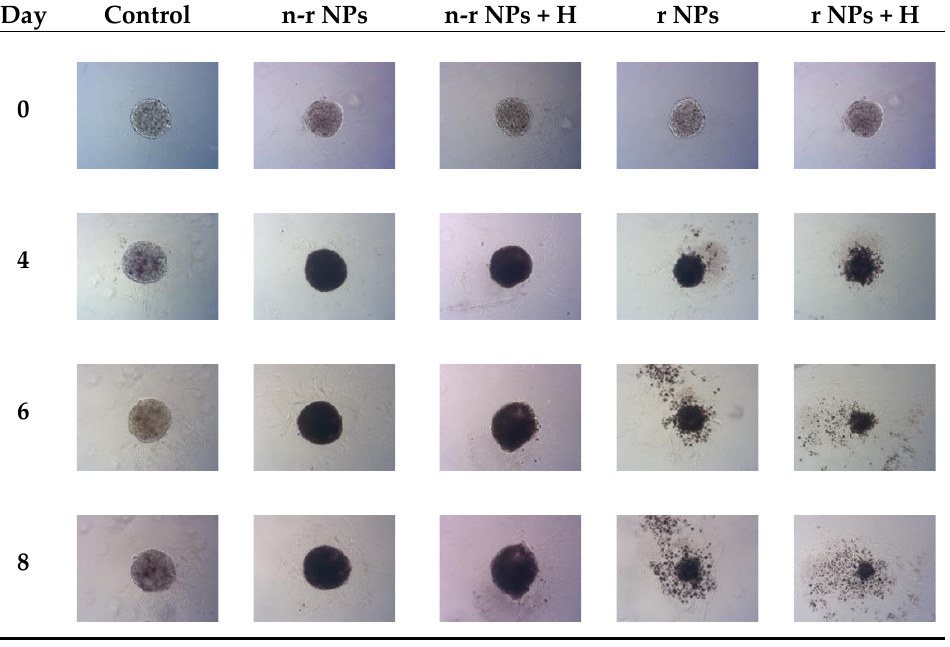
Figure 14. Microscope images of representative spheroids. Images made for spheroids on the day of treatment (Day 0) and on Days 4, 6 and 8 after treatment: n-r — nonradioactive, r — radioactive, H — hyperthermia.